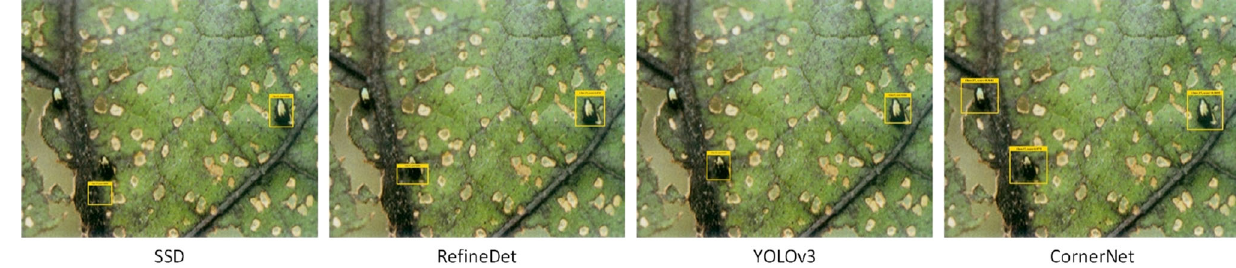
Fig. 10 Sample visual result of SSD, RefineDet, YOLOv3, and the proposed CornerNet